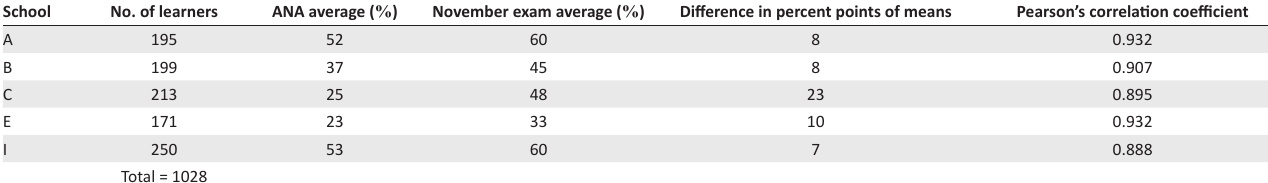
TABLE 2: Correlation between results for ANA and final exams for each